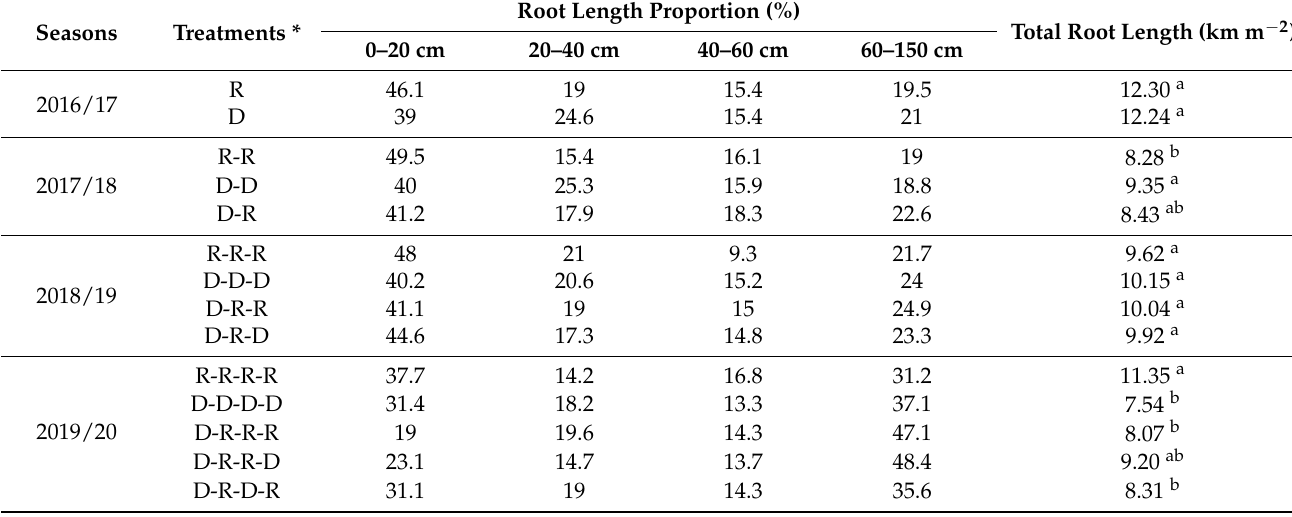
Table 6. Total root length and their proportion at different soil depth at maturity of winter wheat from 2017 to